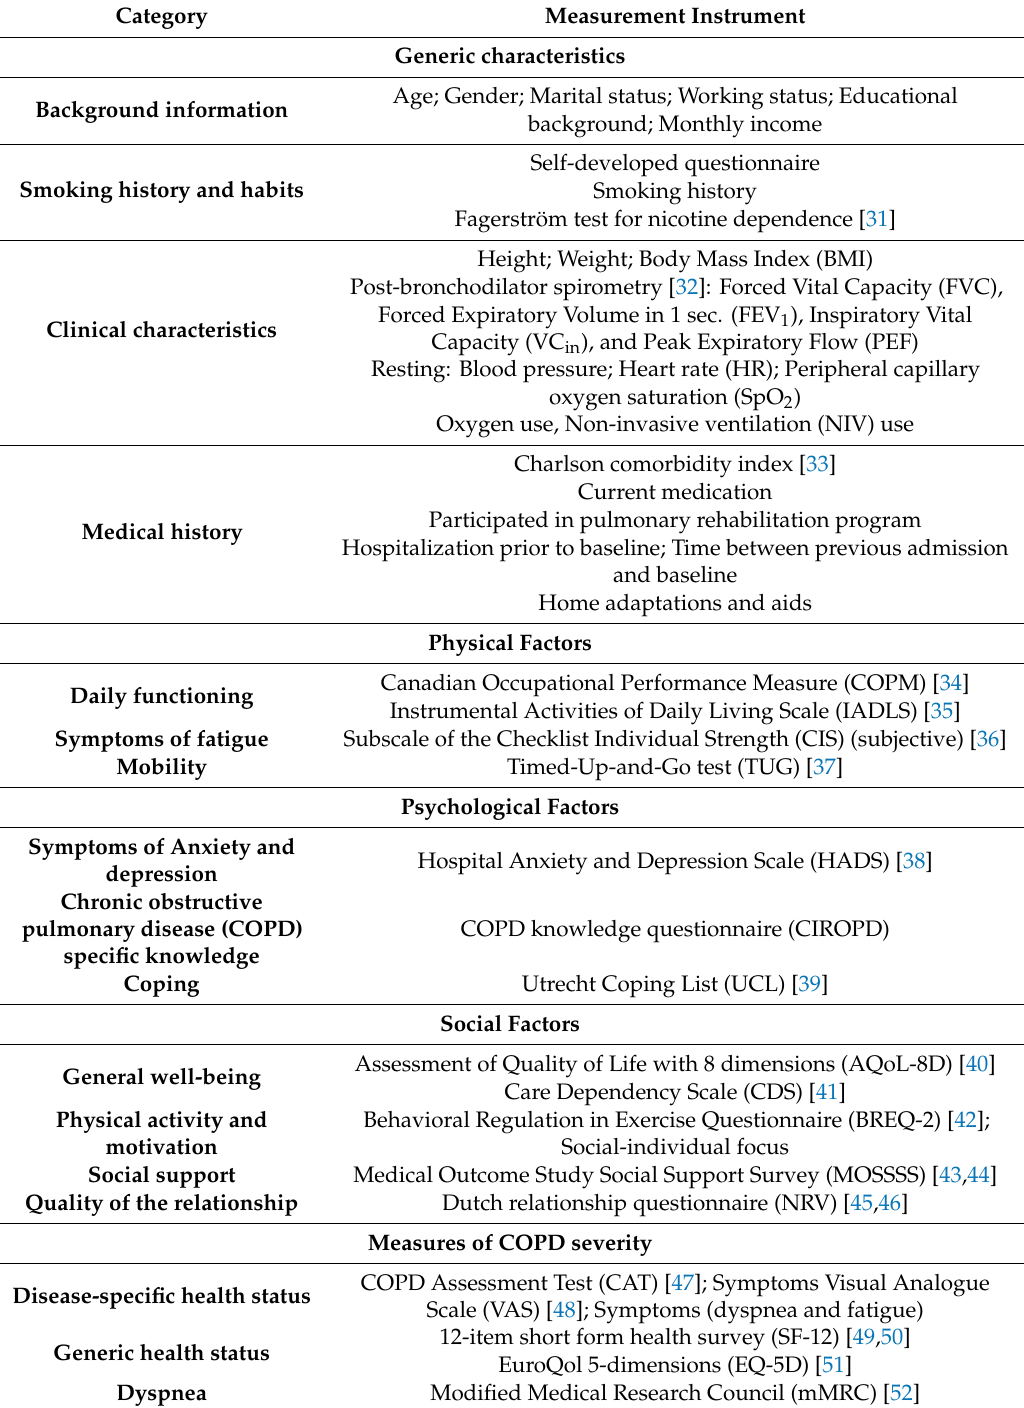
Table 1. Overview of all measurements performed at